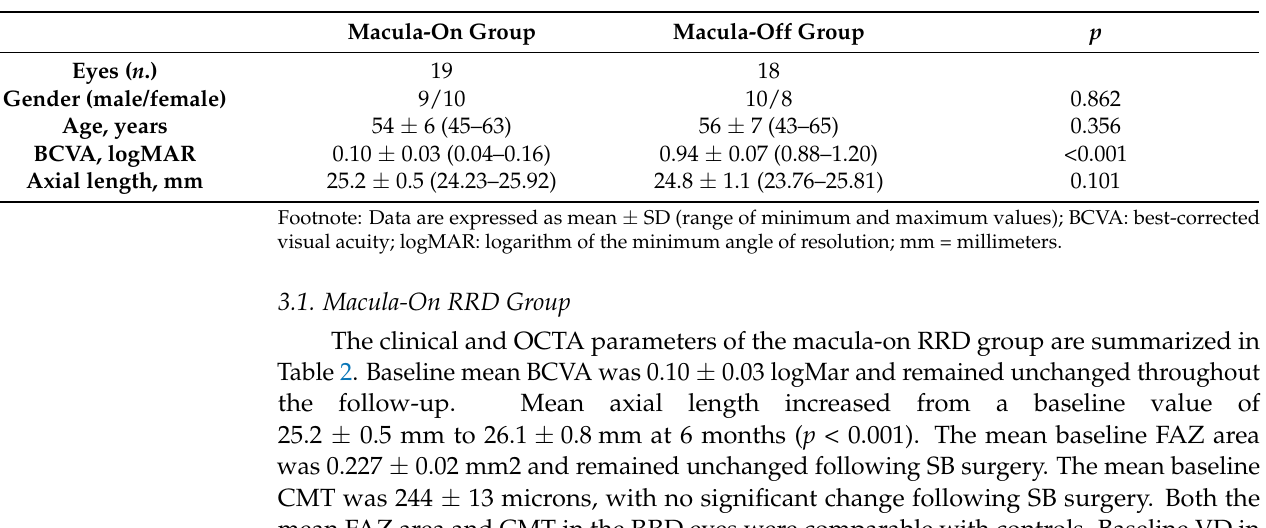
Mean axial length increased from a baseline value